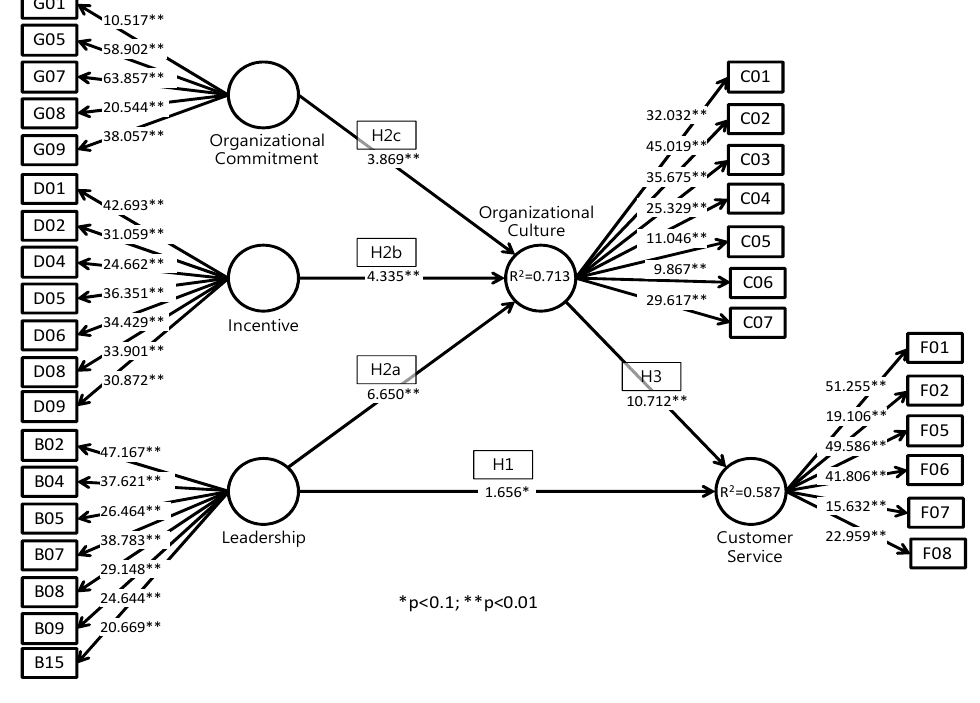
Figure 5. Bootstrapping results.